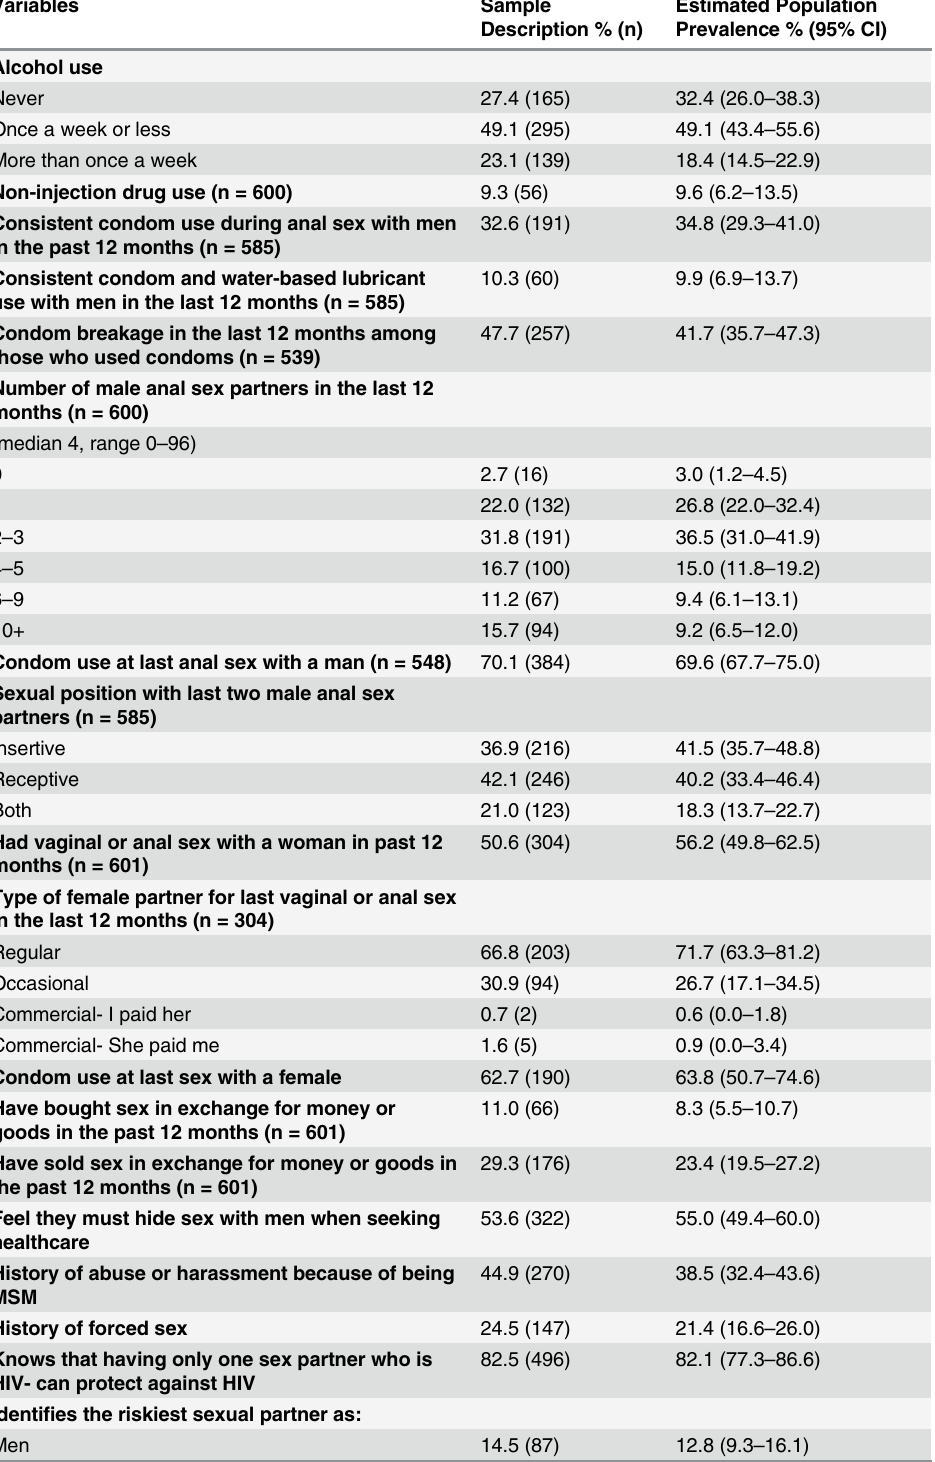
Table 2. Behavioral & Knowledge Characteristics of MSM in Abidjan, Côte d ’ Ivoire, 2011 – 2012 (n =